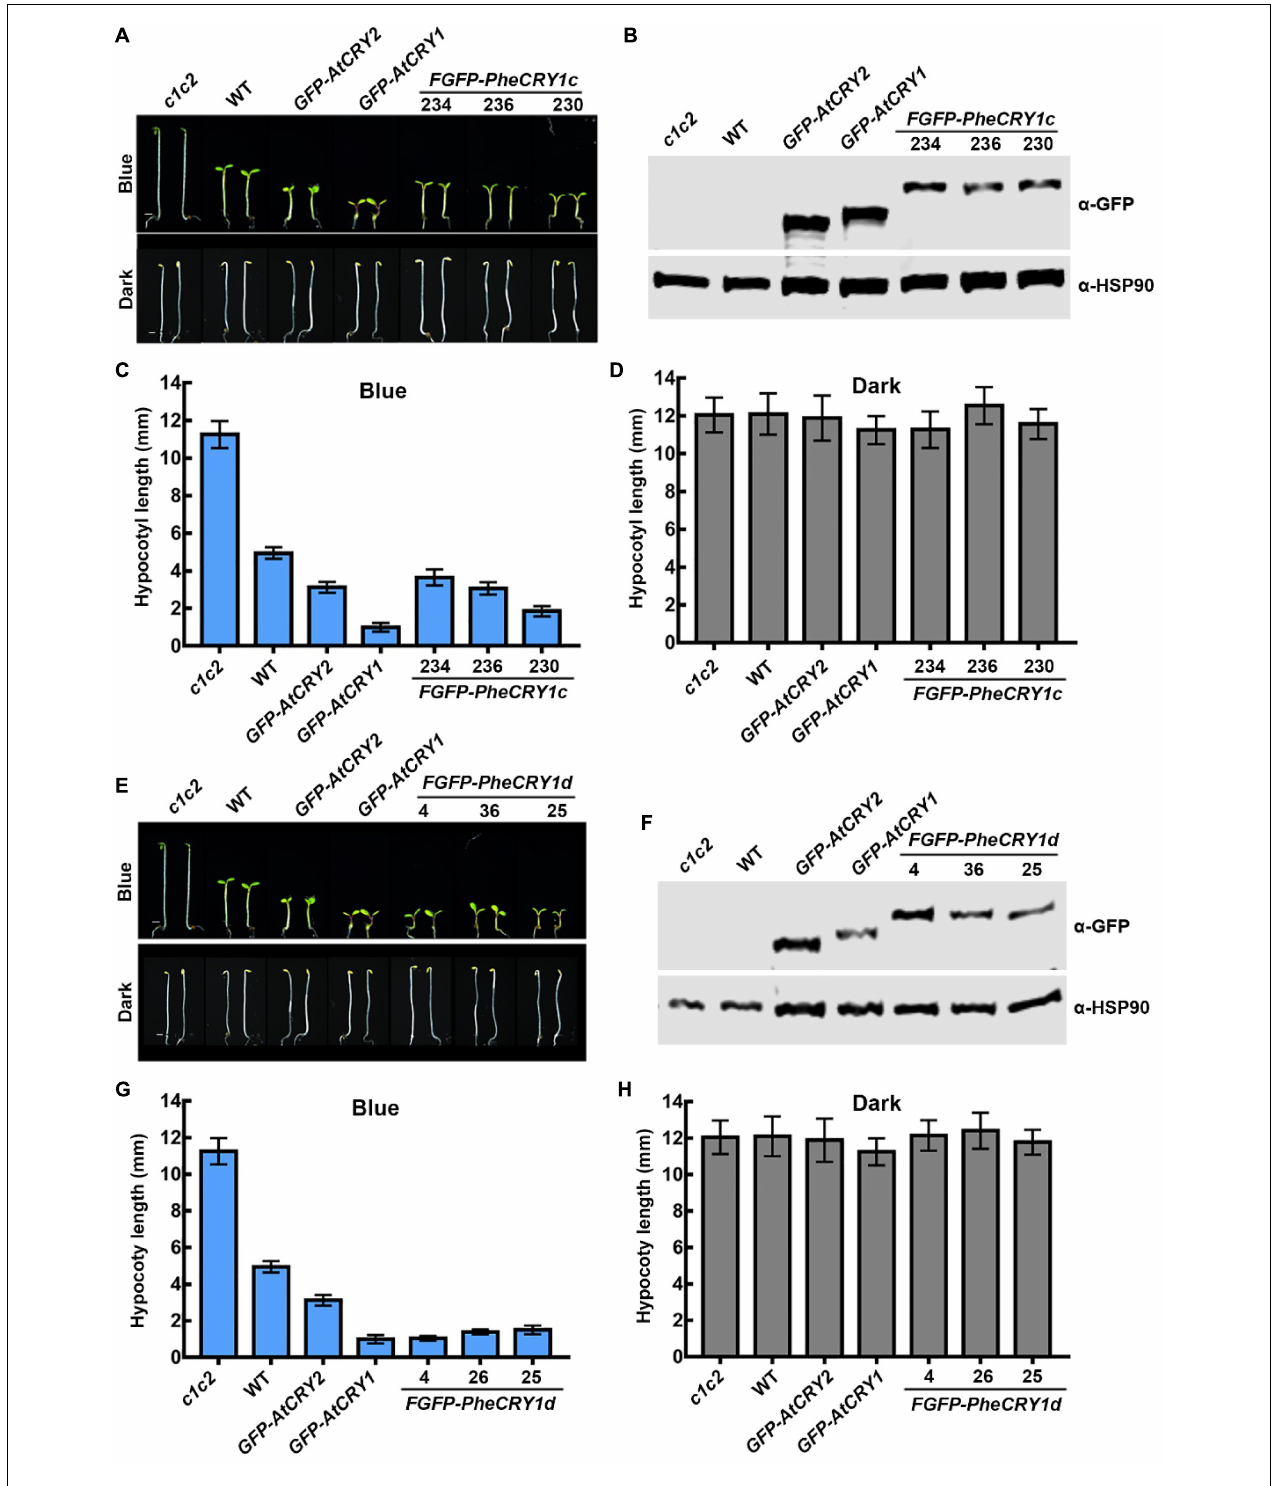
FIGURE 1 | Bamboo PheCRY1s mediate blue light inhibition of hypocotyl elongation. (A,E) Images of 5-day-old Arabidopsis seedings grown under continuous blue light (10 µ molm − 2 s − 1 ) or darkness. Scale bar, 1 mm. (B,F) Immunoblots showing the expression of FGFP-PheCRY1c (B) or FGFP-PheCRY1d (F) of seedlings shown in (A) or (E) . PheCRY1 and HSP90 were detected with anti-GFP antibody or anti-HSP90 antibody, respectively. HSP90 is used as a loading control. (C,D) Measurements of hypocotyl length of seedlings shown in (A) , (mean ± SD, n ≥ 20). (G,H) Measurements of hypocotyl length of seedlings shown in (E) , (mean ± SD, n ≥